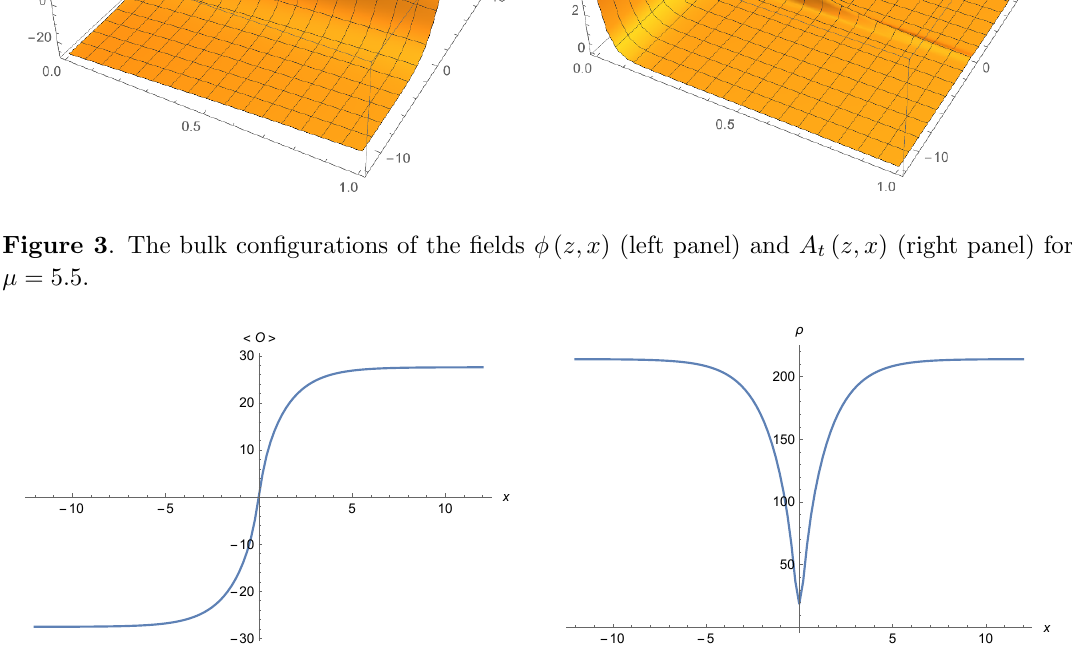
Figure 4 . The order parameter (left panel) and particle number density (right panel) with respect to x for (cid:22) = 5 :